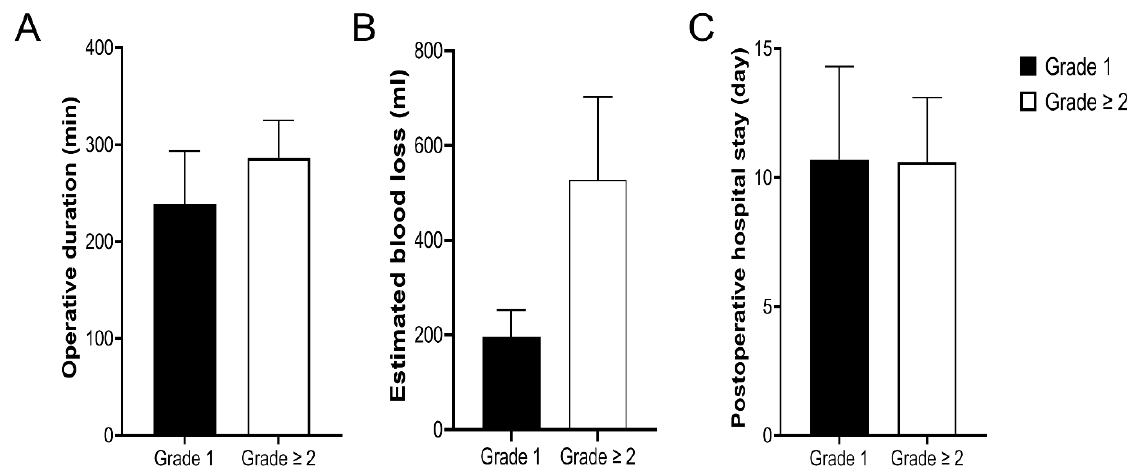
Figure 4. Differences in operative duration ( A ), estimated blood loss ( B ), and postoperative hospital stay ( C ) according to the surgical field grade. A significant decrease in operative duration ( p = 0.001) and estimated blood loss ( p < 0.001) was observed among donors with surgical field grade 1 compared with those with surgical field grade ≥ 2. However, there was no significant difference in postoperative hospital stay between the two groups ( p = 0.988).